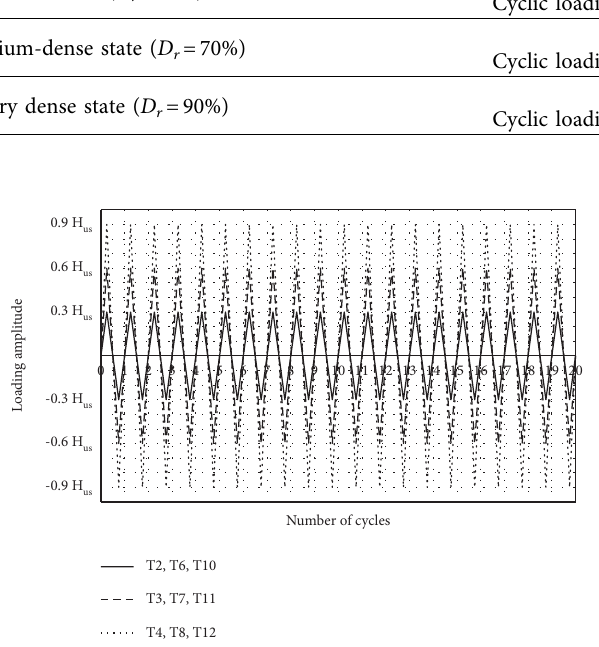
Figure 3: Sequence of cyclic lateral